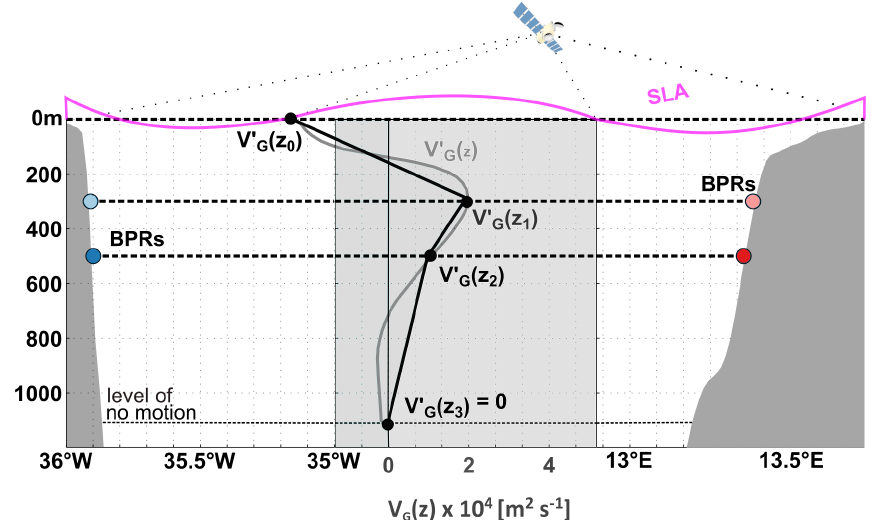
Figure 3. Experimental setup and strategy to estimate T (cid:48) showing the location of the BPRs (reddish and blueish circles) and the vertical G sampling of V (cid:48) . V (cid:48) is derived from measurements of sea level anomaly and with bottom pressure at 300 and 500m depth. A level of G G (z) : (i) piecewise linear interpolation of V (cid:48) no motion is prescribed to be at z 3 = − 1130m. Two methods are used to approximate V (cid:48) G G between the four data points (black profile) and (ii) regression of the first and second dominant vertical structure functions of V (cid:48) GSIM P(z) (z) is then from INALT01 onto the data points at 0, 300 and 500m depth relaxing the no-flow condition at 1130m depth (grey profile). V (cid:48) G vertically integrated from 1130m to the surface to derive T (cid:48) G